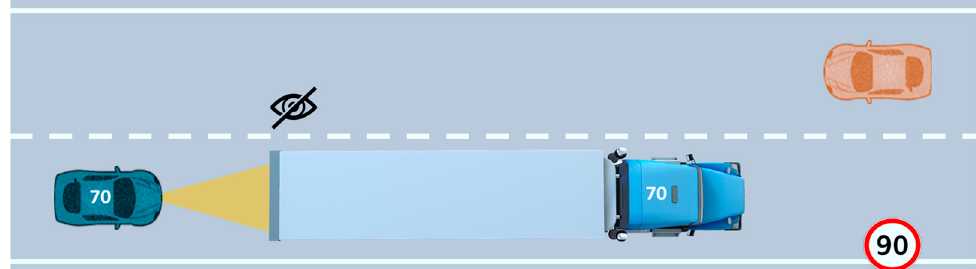
Figure 1. The overtaking scenario on a road with oncoming traffic.